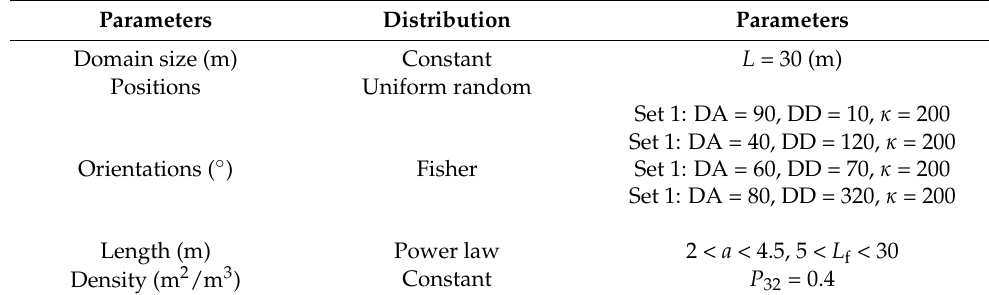
Table 1. Parameters used for the generation of DFNs in Section 3.2.